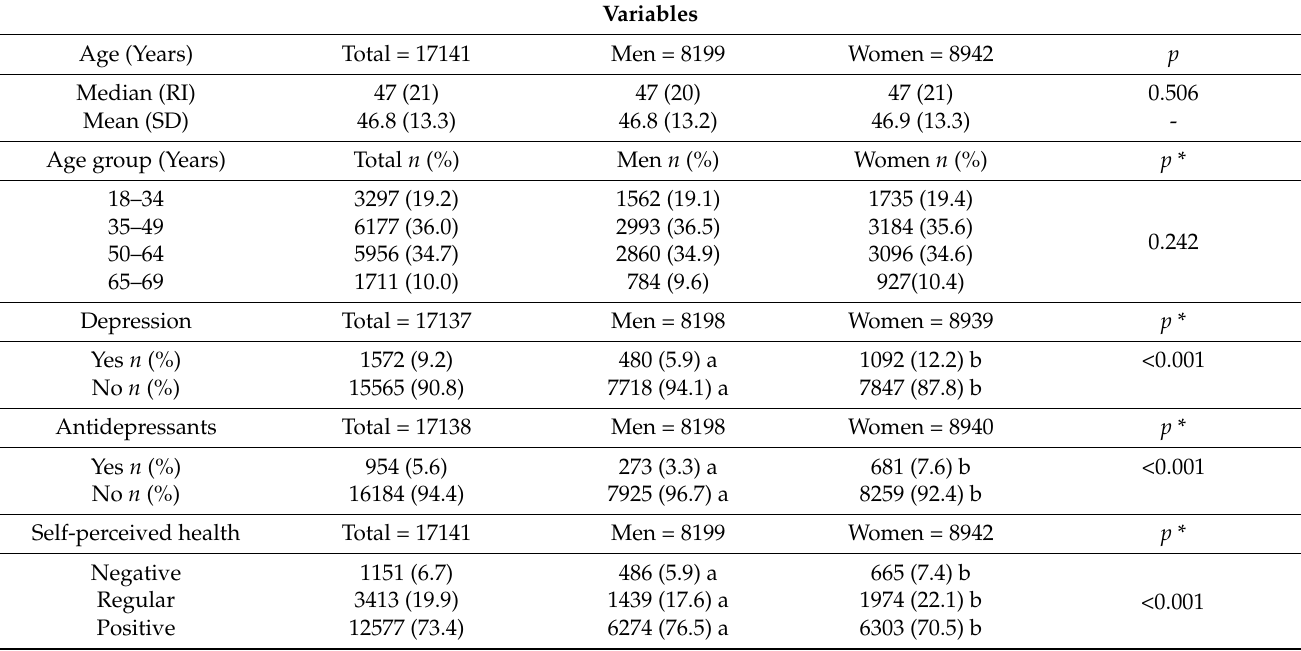
Table 1. Sociodemographic characteristics, prevalence of depression, use of antidepressants and level of physical activity in the Spanish population aged 18–69 years in